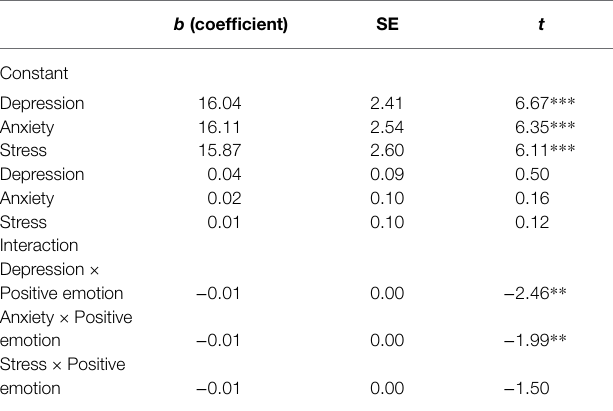
TABLE 5 | Testing the moderation effect of positive emotions on the relationship between depression, anxiety, and stress on psychological